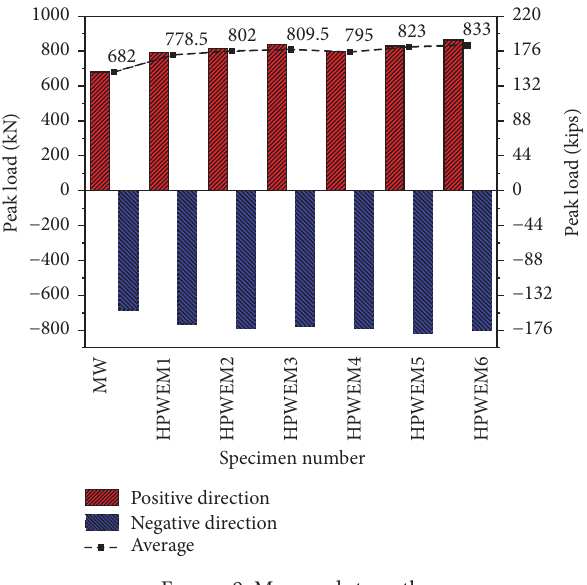
Figure 9: Measured strength.